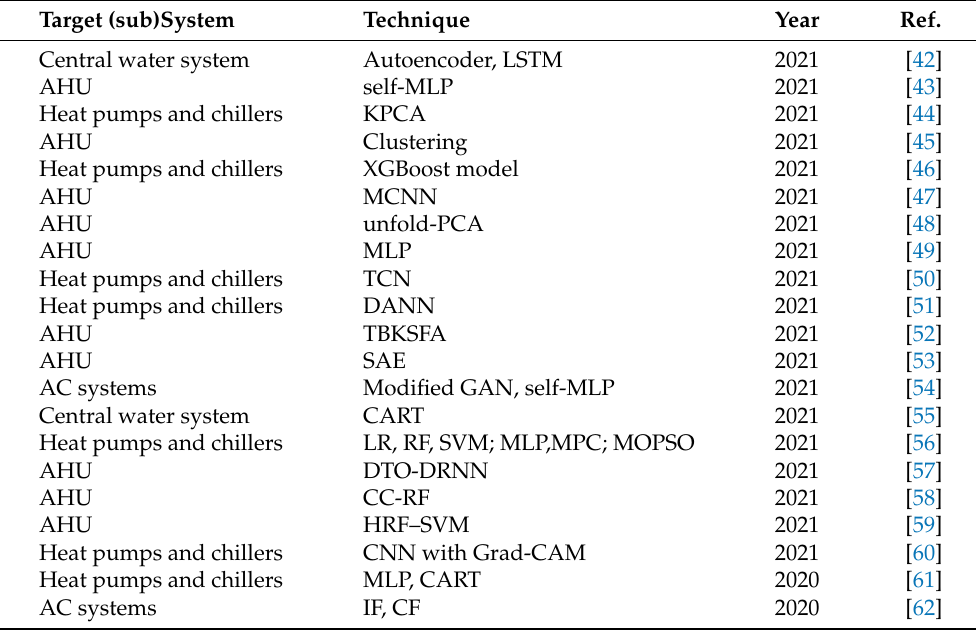
Table 3. Brief summary of related work addressing the data-driven approach in HVAC FDD. For clarity, all acronyms are provided in the Abbreviations